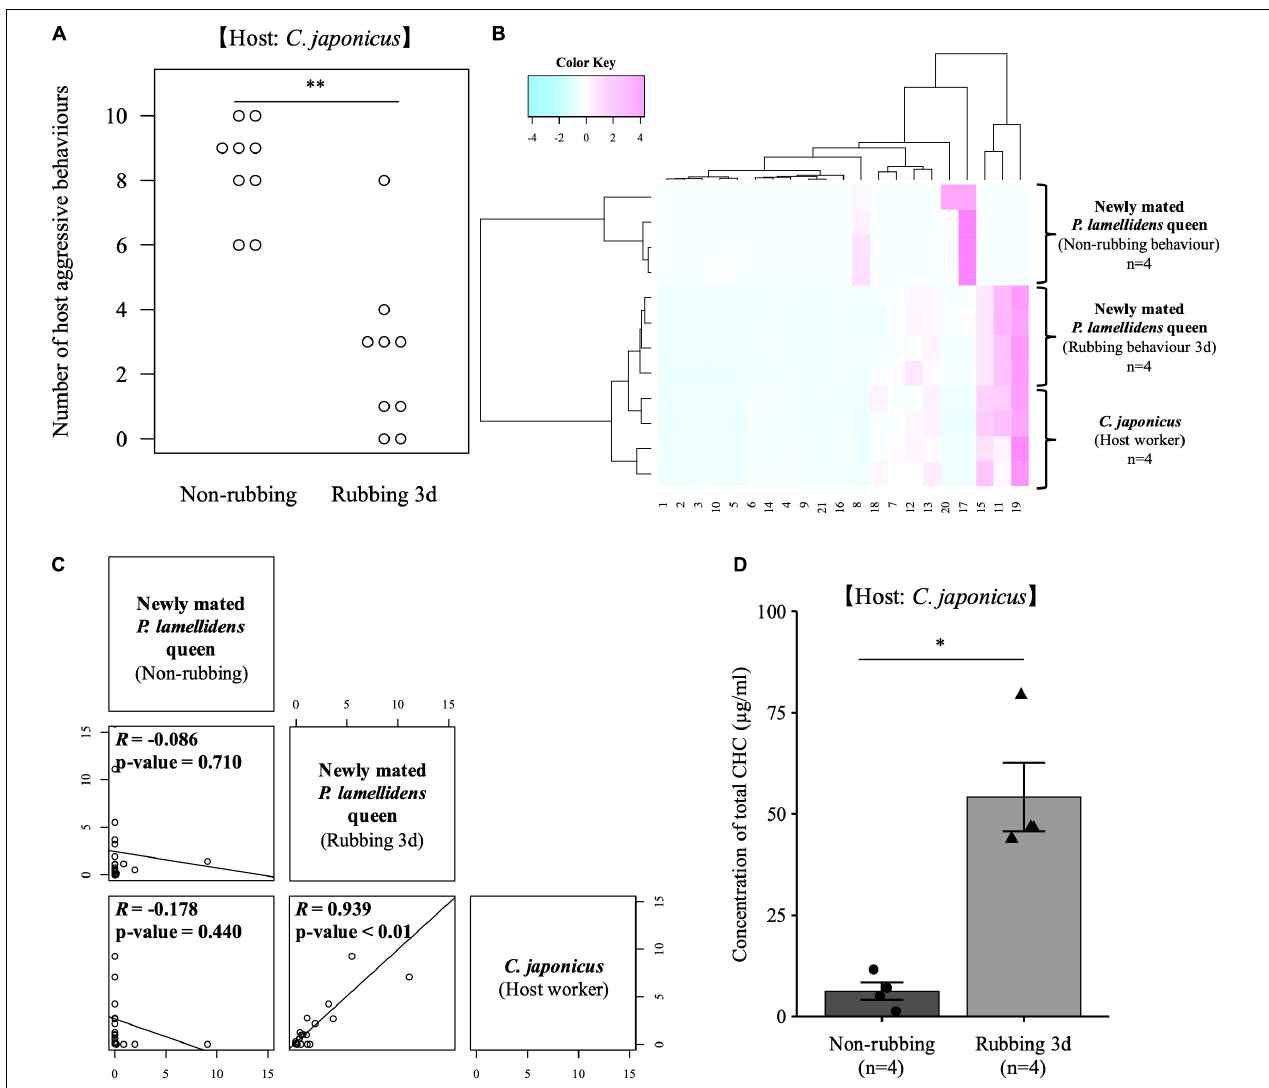
FIGURE 2 | The CHC profile and effect of rubbing behavior on the host worker reaction. We used C. japonicus as a host worker in these experiments. (A) The number of host aggressive behaviors of host workers against newly mated P. lamellidens queens. These host workers were prepared with nine biological replicates, and they belonged to the same colony as that used in the rubbing behavior experiments but with different individuals. Ten actions were observed against the newly mated P. lamellidens queen, and among these actions, “threaten,” “rush,” and “bite” were used to count the number of host aggressive behaviors. Wilcoxon signed rank test, ∗∗ ; significant difference: p -value < 0.01 (the actual value: 0.003). (B) Hierarchical clustering analysis of CHC profiles of newly mated P. lamellidens queens and host workers. This analysis was performed using the standardized value of the peak area that was converted to a Z score. The x -axis indicates the type of estimated hydrocarbons (see Supplementary Table 2 ). (C) Correlation analysis of CHC profiles of newly mated P. lamellidens queens and host workers. The correlation coefficient was calculated by the Pearson method. R indicates the correlation coefficient. Each plot shows the detected cuticular hydrocarbons. The x -axis and the y -axis show the area values of the standardized average peak area value. (D) The concentration of CHC in newly mated P. lamellidens queens. Mann–Whitney U test, ∗ ; significant difference: p -value < 0.05 (the actual value: 0.028), n = 4. Error bar indicates standard